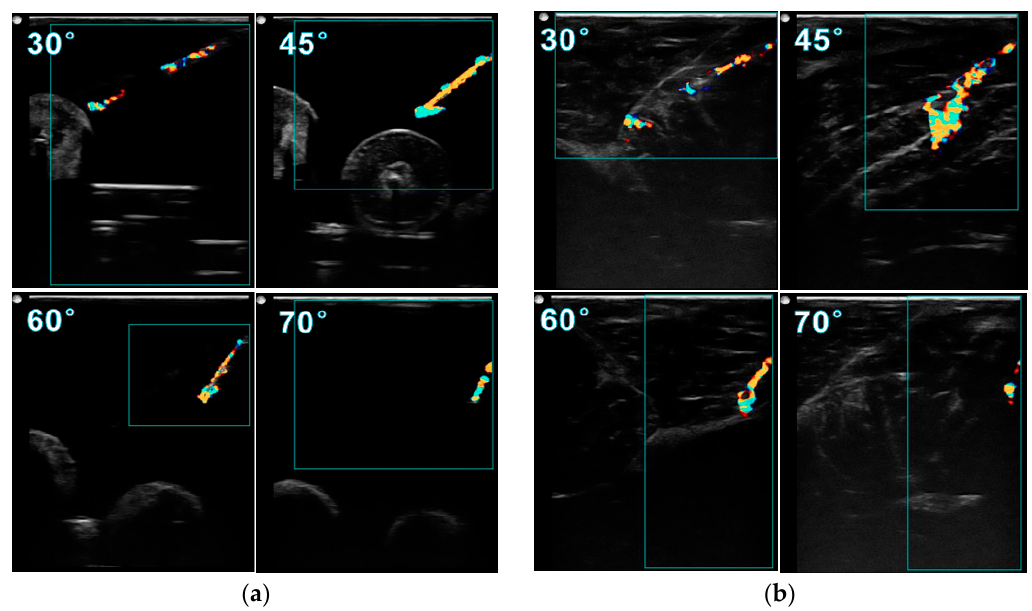
Figure 6. Visualized vibrating needle in ( a ) gelatin phantom and ( b ) porcine tissue with a voltage of 45 V and a depth of 2 cm at insertion angles of 30, 45, 60, 70°.